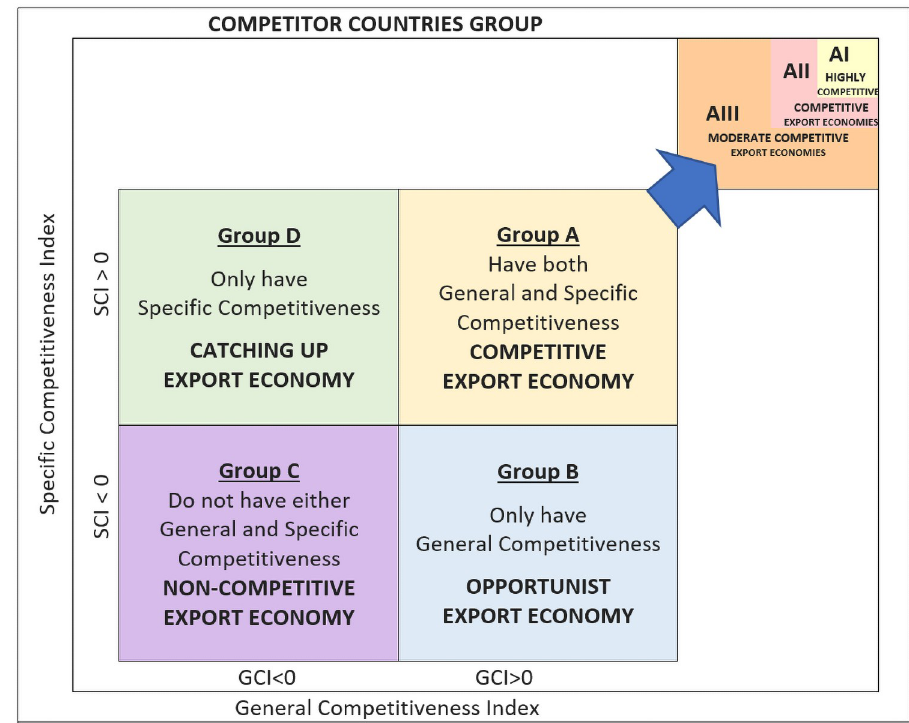
Fig 15. Two-dimensional export competitiveness system for Constant Market